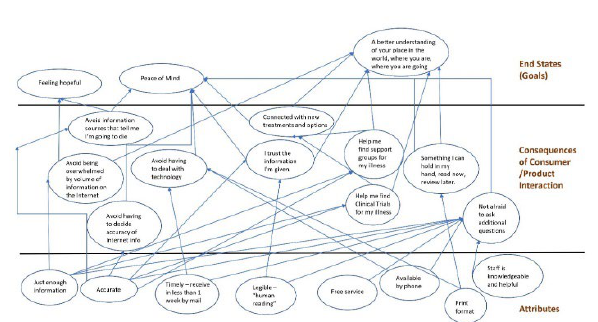
Figure 3 Customer Value Hierarchy for